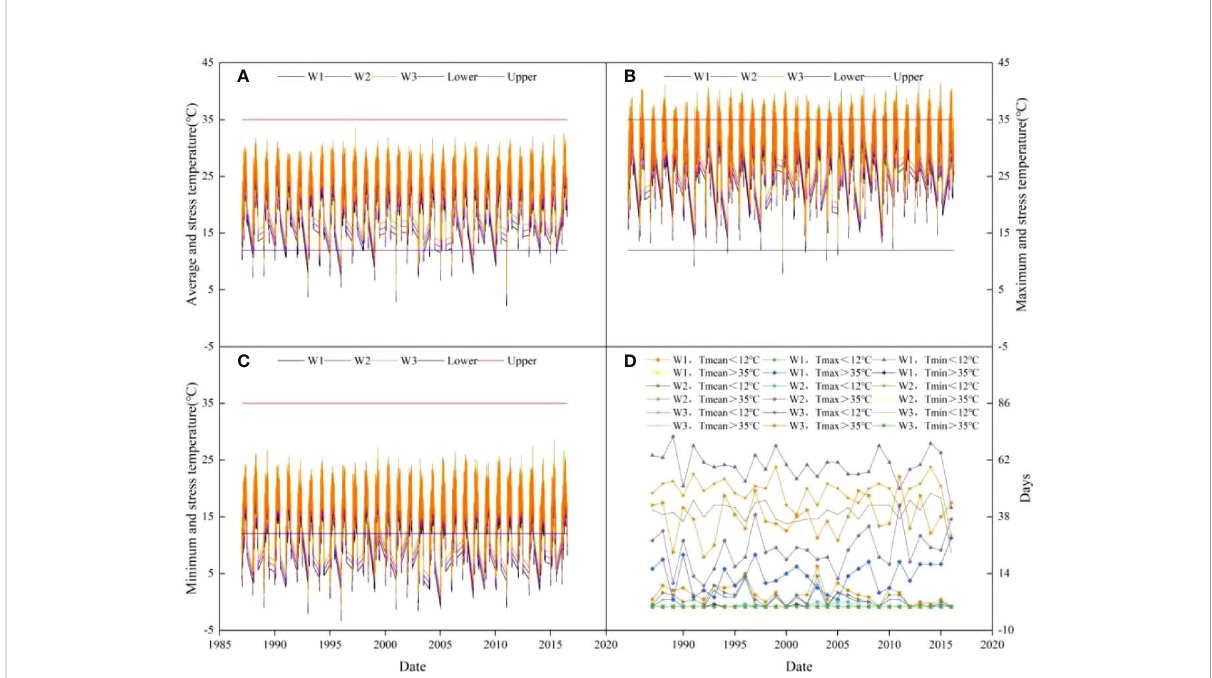
FIGURE 3 Atmospheric temperature change and the number of days that are affected by temperature stress during the cotton growth period under climate change from 1987 to 2016. (A) Average and stress temperature. (B) Maximum and stress temperature. (C) Minimum and stress temperature. (D) Stress